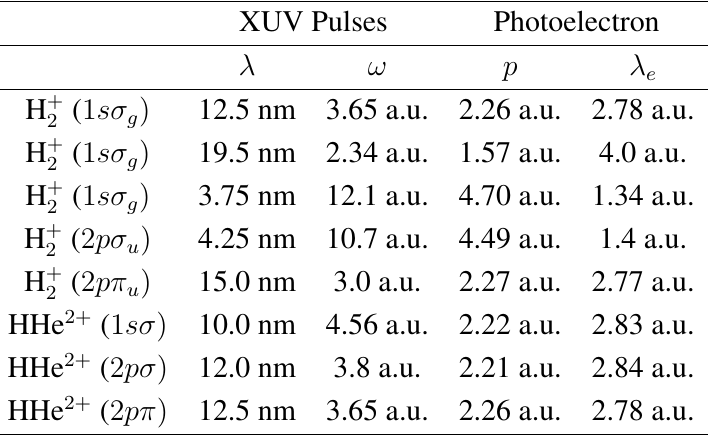
2 pπ Figure 3. Angle θ resolved MAPES for the x oriented ( Θ = 0 ◦ ) H + excited state u 2 = 5 × 10 14 W/cm 2 , wavelength λ = 15 nm and duration at equilibrium with intensity I 0 T = 402 as XUV laser pulses for ( a , left column) linear x parallel polarization, and ( b , right column) linear y perpendicular (to molecular internuclear R axis) polarization ionizations. Dashed lines denote the critical angles ϑ . Signal intensities of the ionization spectra are on c a logarithmic scale in arbitrary units. Adapted from [24]. Table 1. Momenta p and wavelengths λ of a photoelectron calculated by p 2 / 2 = ω − I and e p λ = 2 π/p for different electronic states of the molecular ions H + and HHe 2+ at R = 2 a.u. e 2 by varying the wavelength λ (angular frequency ω ) of XUV laser